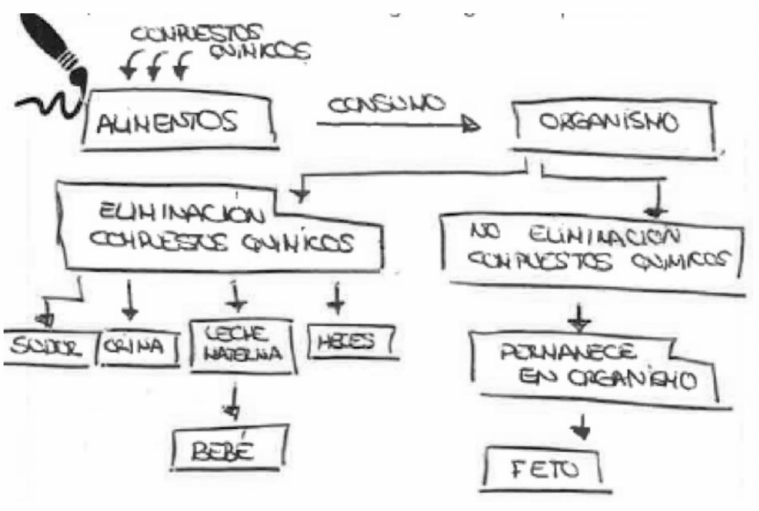
Figure 11. Pregnant, university education,